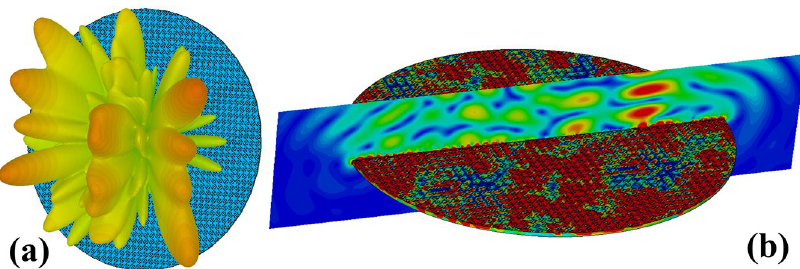
Figure 10. Simulated far-field and near-field patterns of the rotating diffusion metasurface under normal incidence at 1 GHz. ( a ) The far-field scattering pattern. ( b ) The surface current distribution and the near- electric-field distributions of the